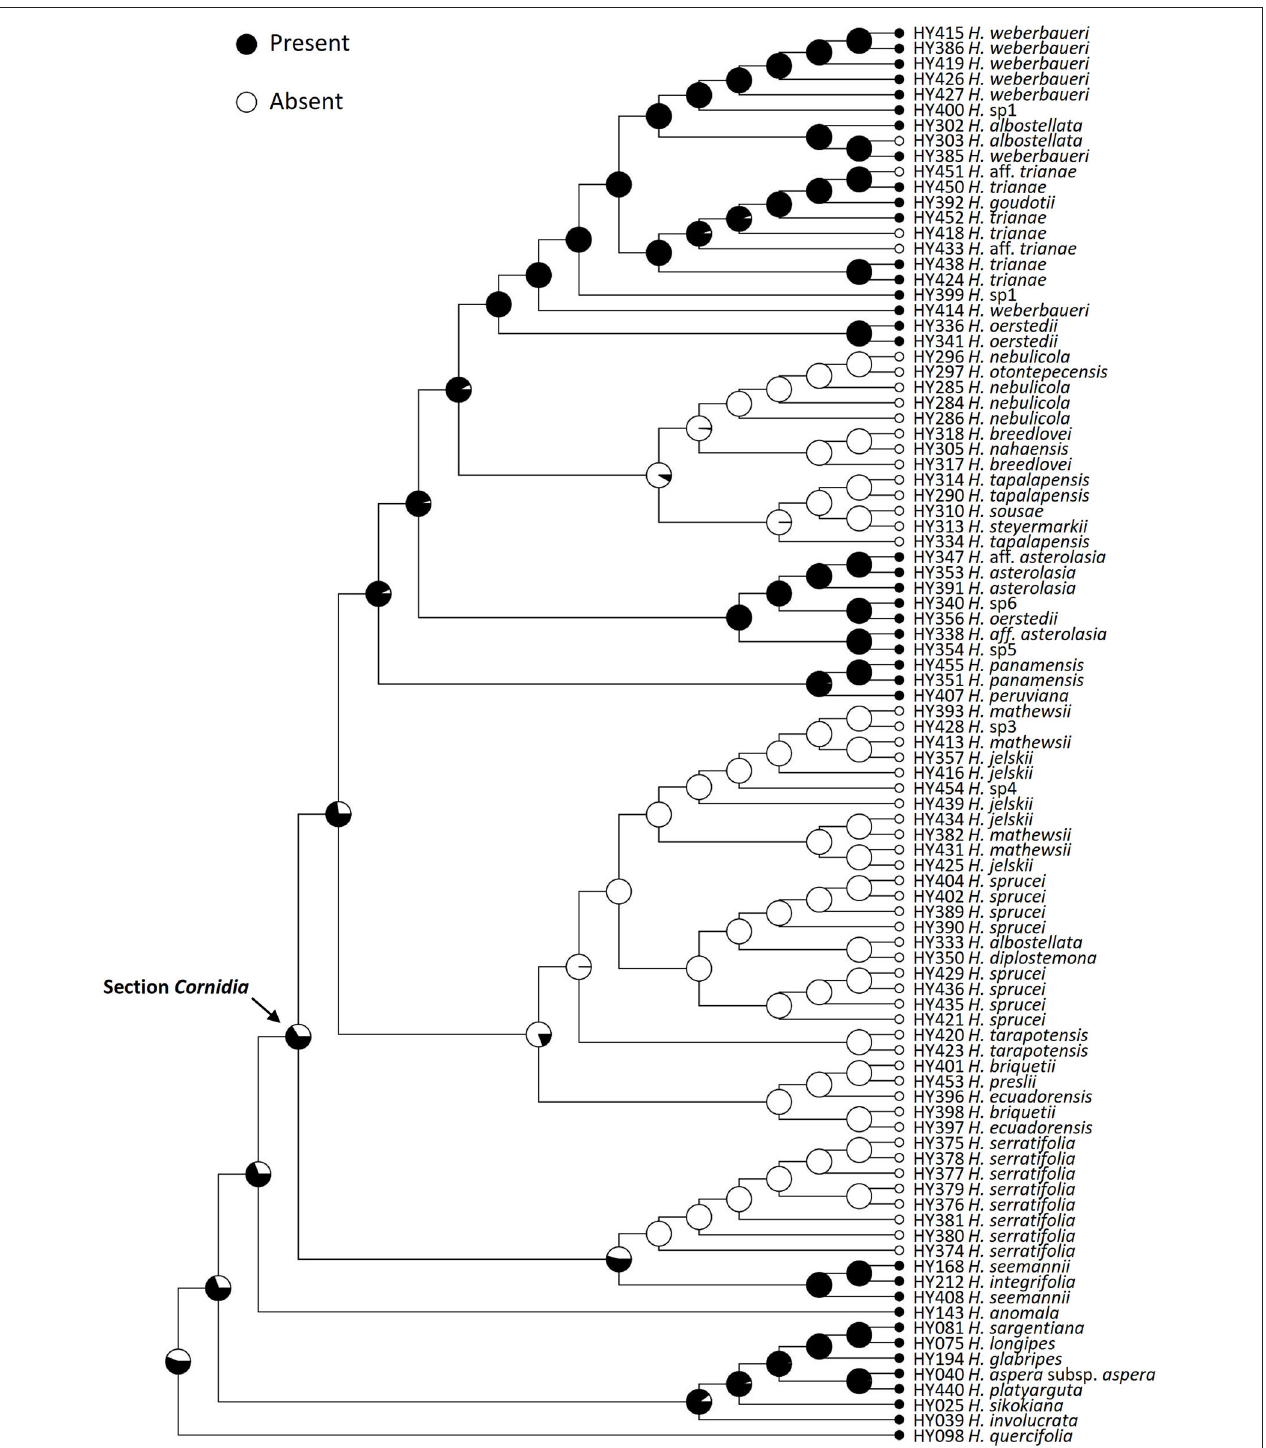
FIGURE 4 | Ancestral reconstruction of the presence of marginal flowers in Hydrangea section Cornidia using Bayesian stochastic character mapping. Pies indicate the proportion for the presence and the absence of marginal flowers from 1,000 simulations on the phylogeny resulting from the combined analysis.